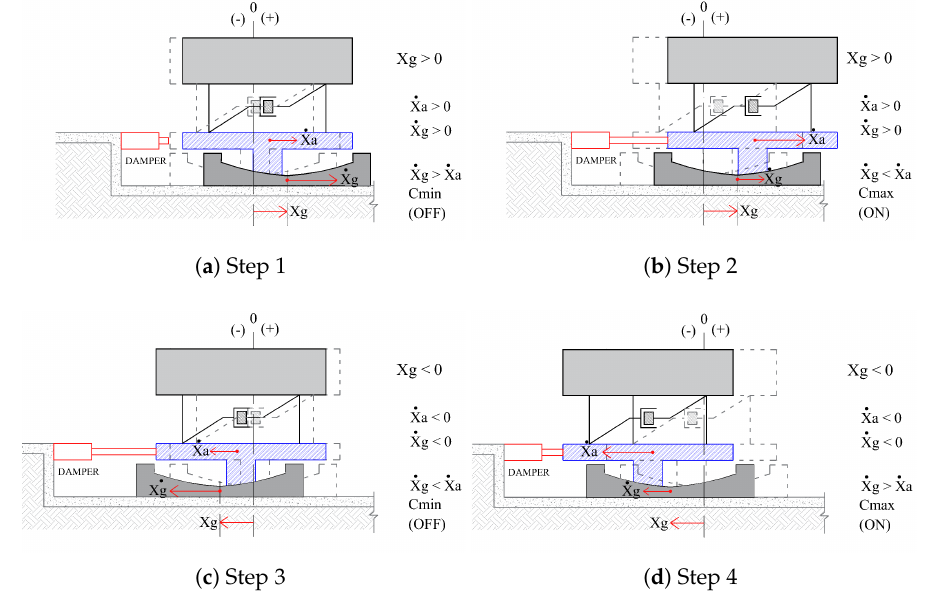
Figure 5. Illustrations of the phase control